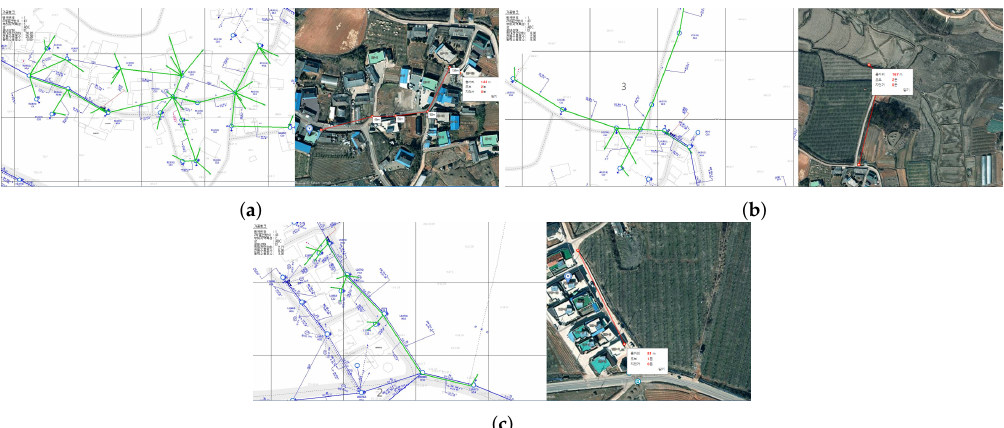
Figure 16. NDIS maps for the Overhead Rural Area. ( a ) Site 3-1. ( b ) Site 3-2. ( c ) Site 3-3.